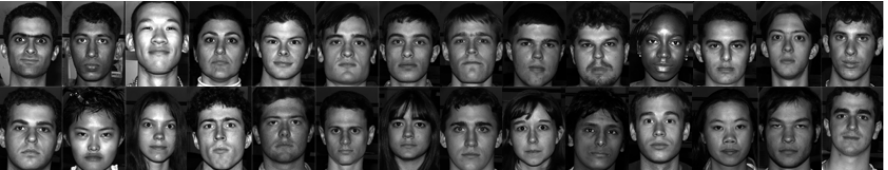
Figure 3. Sample faces images from the Extended Yale B databset.